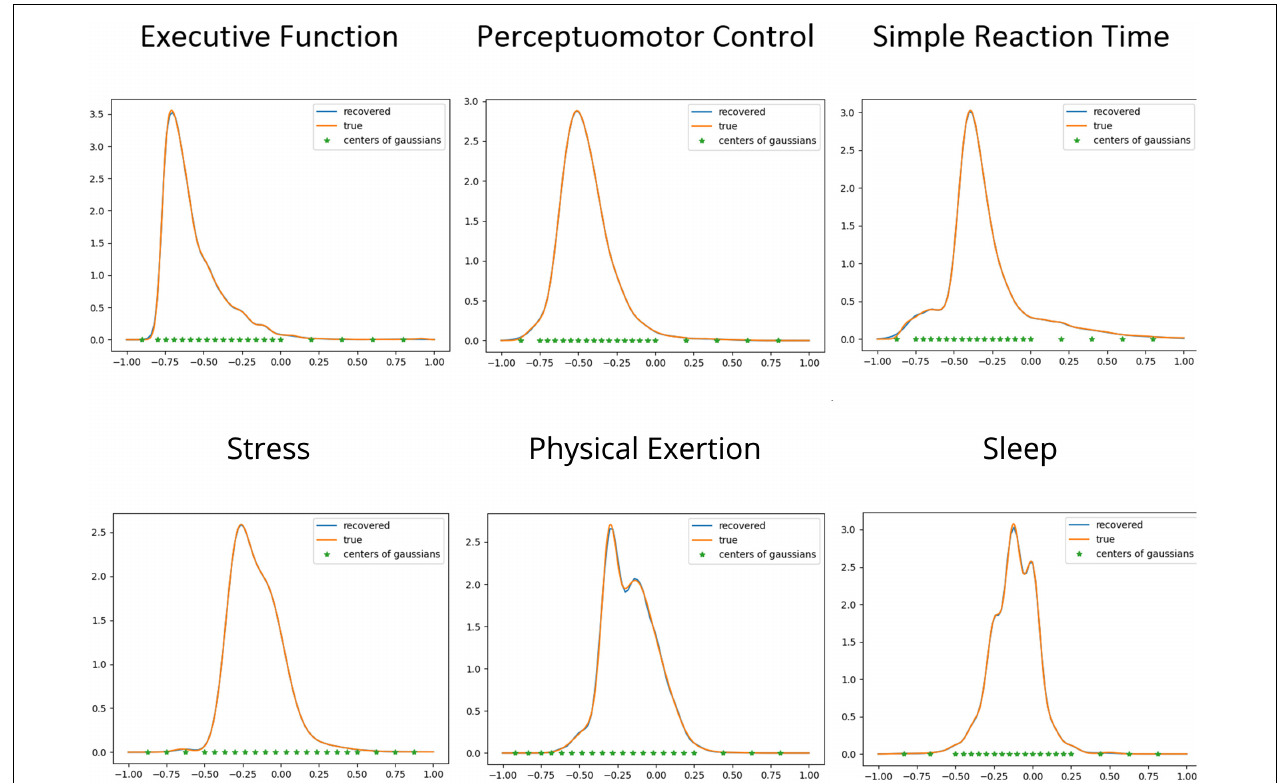
FIGURE 1 | Comparison of true (supplied) and recovered marginal distributions for each of the three dependent (top) and independent (bottom) variables, along with the centers of the Gaussian kernels, which were computed using the LASSO method detailed in section “Gathering Model Inputs: Marginal Distributions”. Note, the marginals for the dependent variables were generated after separate runs of the fitting algorithm using all three independent variables. The marginal distributions shown for the independent variables were obtained from the fit using reaction time (the marginal fits of the independent variables using the other two dependent variables displayed an equal level of accuracy). In addition to the fidelity between the LASSO model (recovered) and data-generated (supplied) marginals, we also observe that the KDE and ML methods for recovering marginals were able to resolve a variety of detail and non-Gaussian structure within the distributions. TABLE 4 | Supplied and recovered effect size estimates ( r ) for each of the three independent (rows) and dependent (columns) variables. Simple reaction time Perceptuo-motor control Executive function Recovered Supplied Recovered